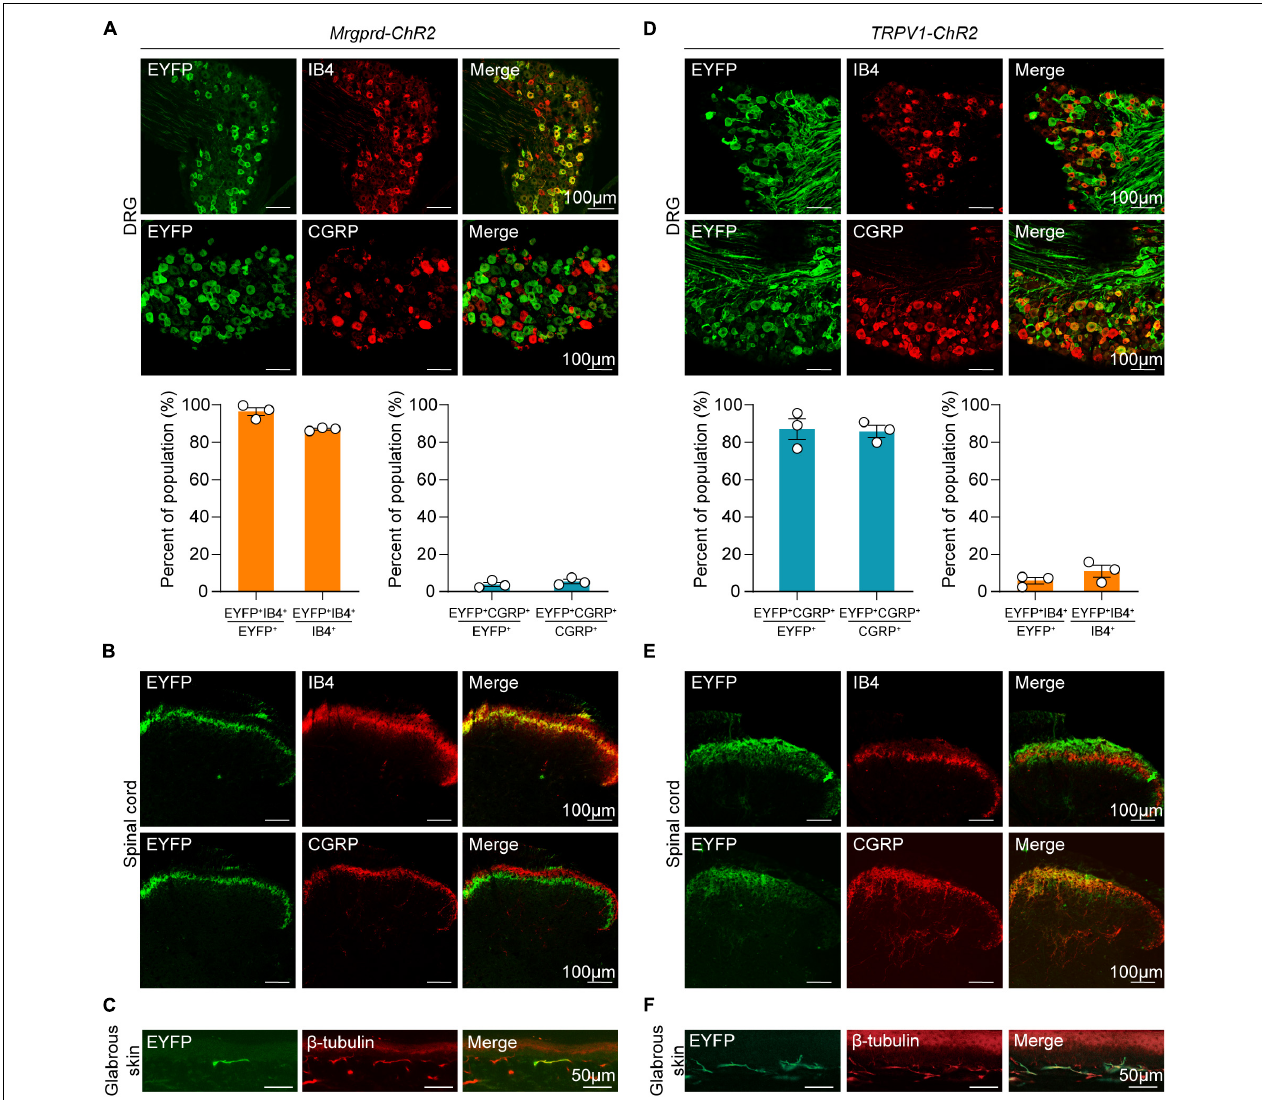
FIGURE 1 | Distinct expression profile of ChR2 in Mrgprd + and TRPV1 + nociceptors. (A) Co-localization of ChR2-EYFP (green) with Alexa-568-conjugated IB4 (red) or CGRP (red) (top) and statistical data for overlap quantification (bottom) in lumbar DRG from Mrgprd-ChR2 mice ( n = 3 animals per group). (B) Representative images of ChR2-EYFP (green) co-stained with IB4 (red) or CGRP (red) in lumbar spinal cord from Mrgprd-ChR2 mice. (C) Representative images of ChR2-EYFP (green) co-stained with β -tubulin (red) in hindpaw glabrous skin from Mrgprd-ChR2 mice. (D) Co-localization of ChR2-EYFP (green) with Alexa-568-conjugated IB4 (red) or CGRP (red) (top) and statistical data for overlap quantification (bottom) in lumbar DRG from TRPV1-ChR2 mice ( n = 3 animals per group). (E) Representative images of ChR2-EYFP (green) co-stained with IB4 (red) or CGRP (red) in lumbar spinal cord from TRPV1-ChR2 mice. (F) Representative images of ChR2-EYFP (green) co-stained with β -tubulin (red) in hindpaw glabrous skin from TRPV1-ChR2 mice. Scale bar = 100 µ m for DRG and spinal cord sections, scale bar = 50 µ m for skin